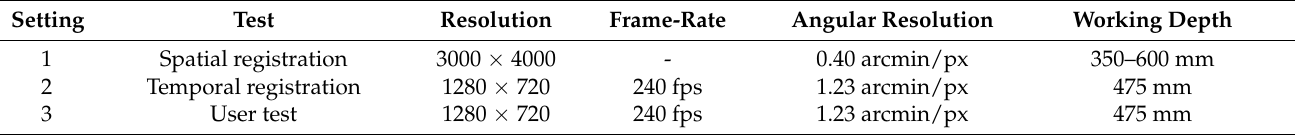
Table 1. GoPro Hero 5 black: settings and